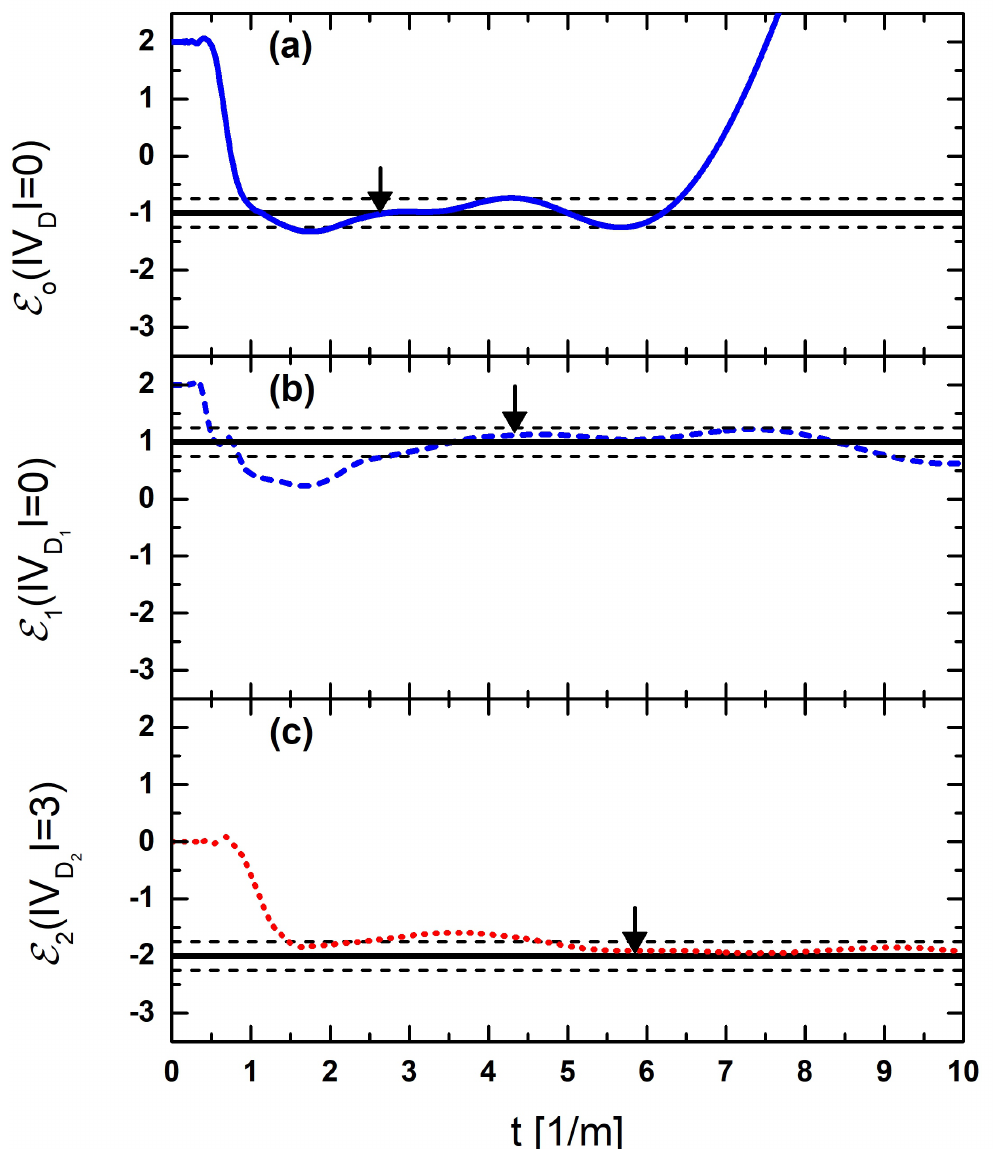
Figure 4. Generalized Euler characteristics calculated for the networks with the standard and mixed boundary conditions as a function of the parameter t . Panels ( a – c ) show the generalized Euler | = 0 ) (blue full line), E ( | V | = 0 ) (blue dashed line), and E ( | V | = 3 ) (red characteristics E o ( | V D D 1 D 2 2 1 o dotted line) of the networks Γ o ( 4,5,0 ) , Γ 1 ( 6,5,0 ) , and Γ 2 ( 4,3,3 ) , respectively. The plateaux at the plots = 2.63 m − 1 , of the generalized Euler characteristics shown in panels ( a – c ) start close to the points t 0 o = 4.33 m − 1 , and t = 5.85 m − 1 , respectively, which are marked by the arrows. The black broken t 0 0 2 1 | = 0 ) ± 1/4, E ( | V | = 0 ) ± 1/4, lines show the limits of the assumed maximum errors E o ( | V D D 1 1 o | = 3 ) ± and E 2 ( | V D 2